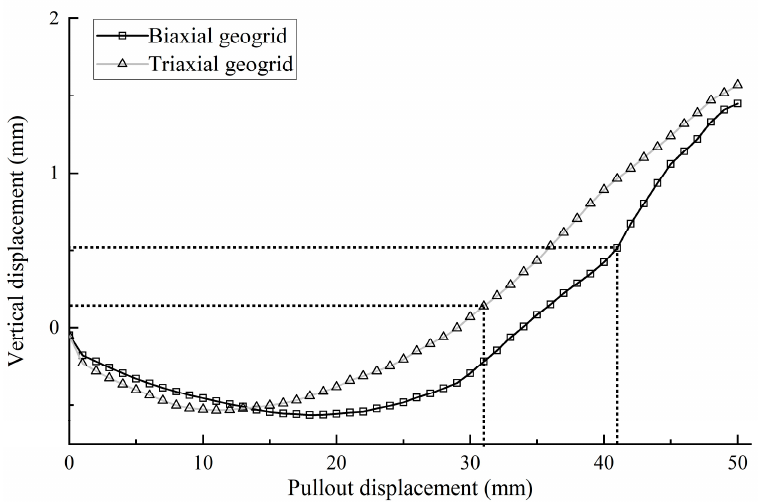
Figure 14. Average vertical displacement of surcharge block.